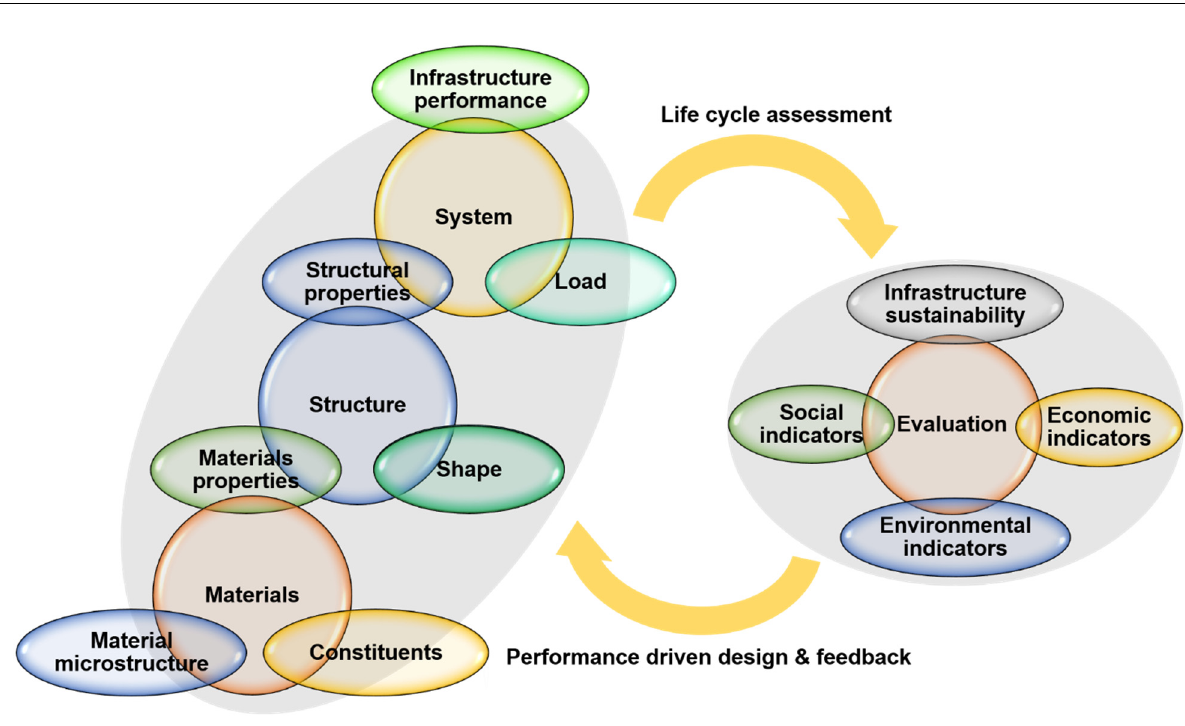
Figure 1. The Integrated Structures and Materials Design (ISMD) applied to Infrastructure Systems.